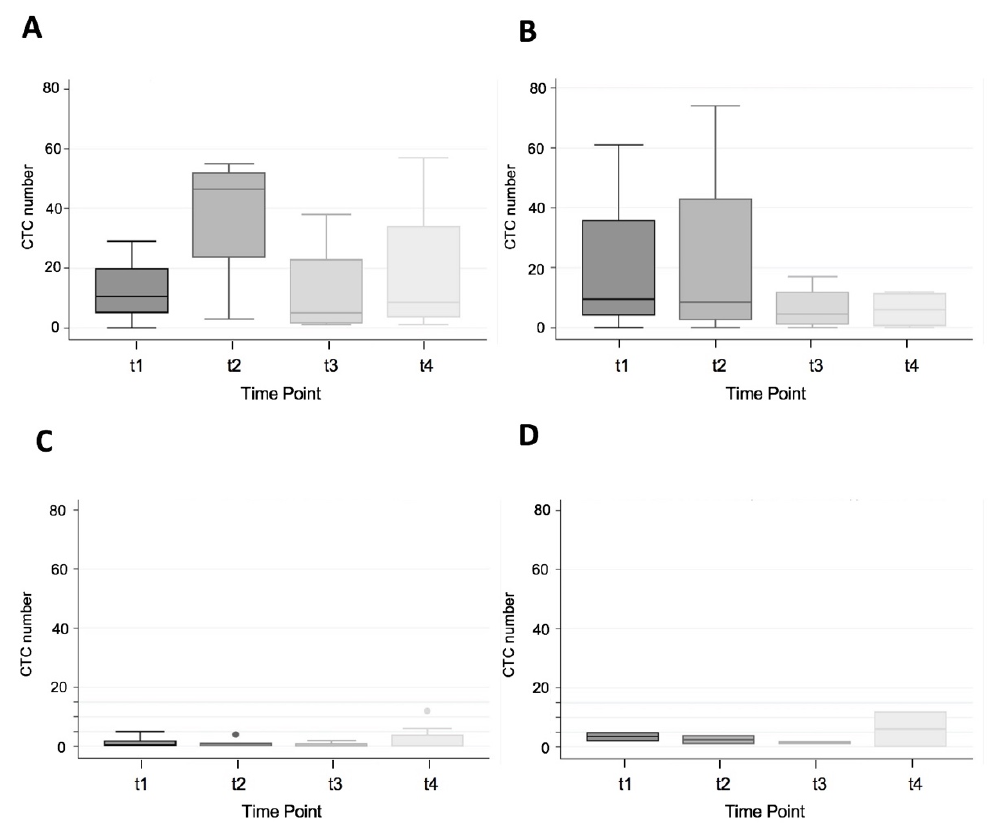
Figure 3. CTC number and MSI status for right-sided stage I-III colon cancer, (Panel A ) MSS, (Panel B ) MSI-H and CTC number for left-sided colorectal cancer, no neoadjuvant (Panel C ), and neoadjuvant therapy (Panel D ) at sample time points t1 (pre-operative), t2 (Intra-operative), t3 (immediate post-operative), t4 (14–16 h post-operative).